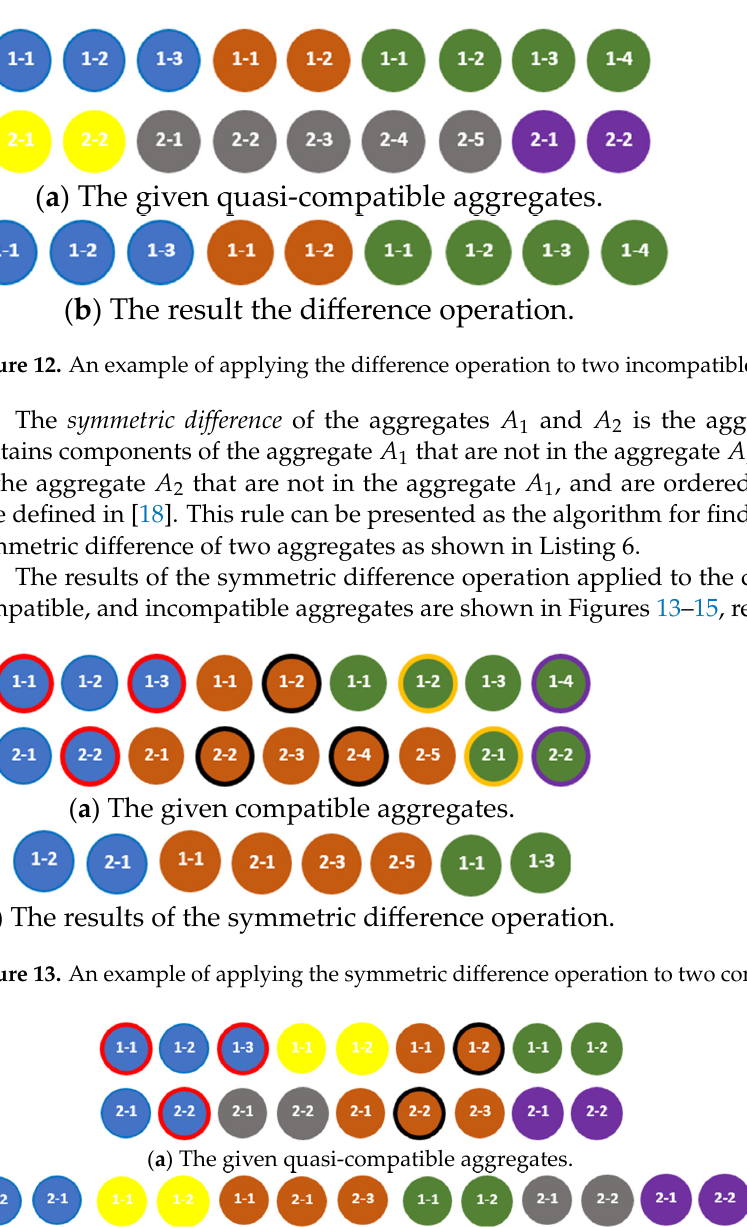
Algorithms 2023 , 16 , x FOR PEER REVIEW Figure 11. An example of applying the di ff erence operation to two quasi-compatible aggregates. Figure 11. An example of applying the difference operation to two quasi-compatible aggregates.